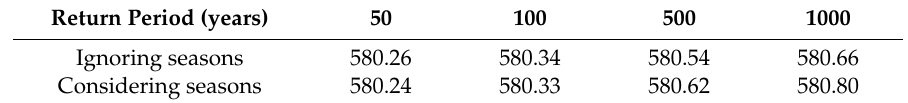
Table 12. E ff ect of statistical consideration of seasonality on maximum flood water levels (MWRL).